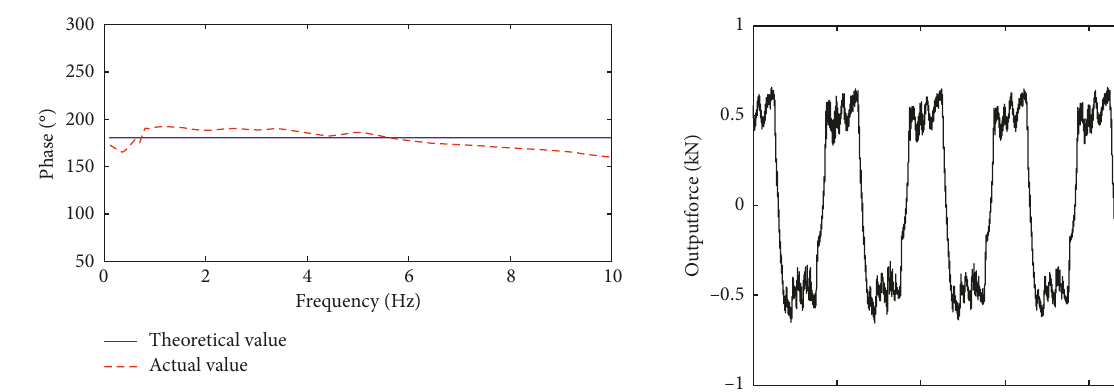
Figure 4: Phase-frequency characteristic of the hydraulic electric inerter.